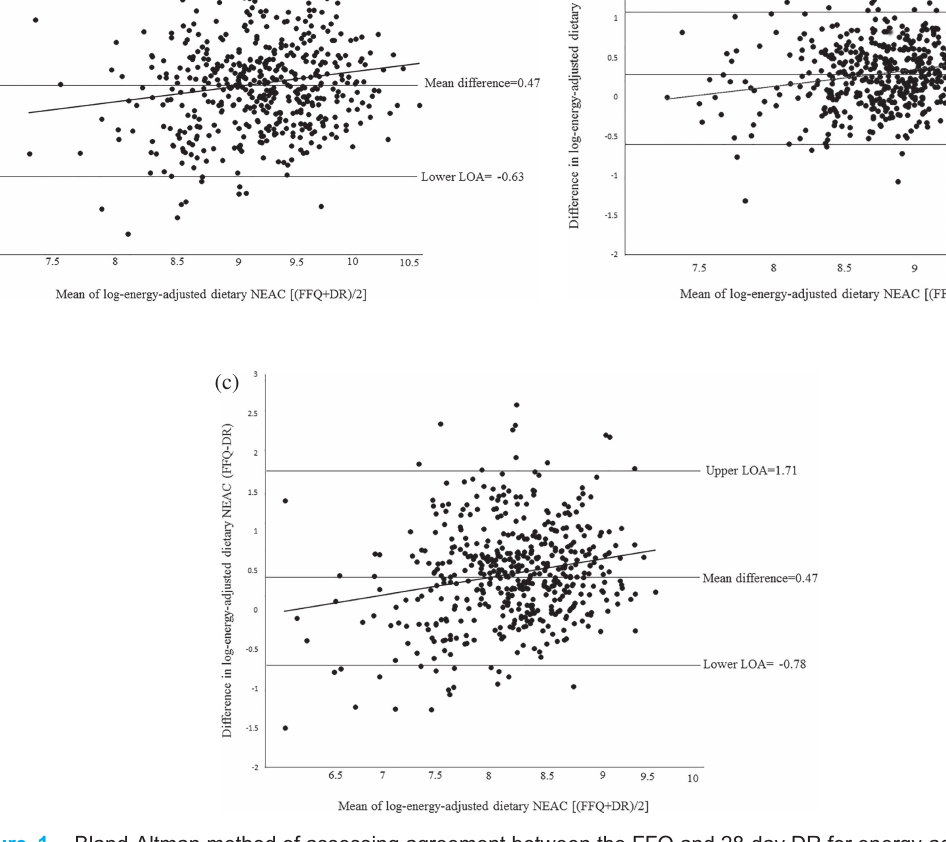
Figure 1. Bland-Altman method of assessing agreement between the FFQ and 28-day DR for energy-adjusted dietary NEAC in (a) FRAP (y = 0.1831x % 1.2309; P < 0.01), (b) ORAC (y = 0.2209x % 1.6309; P < 0.01), and (c) TRAP (y = 0.2391x % 1.5024; P < 0.01). DR, dietary record; FFQ, food frequency questionnaire; LOA, limit of